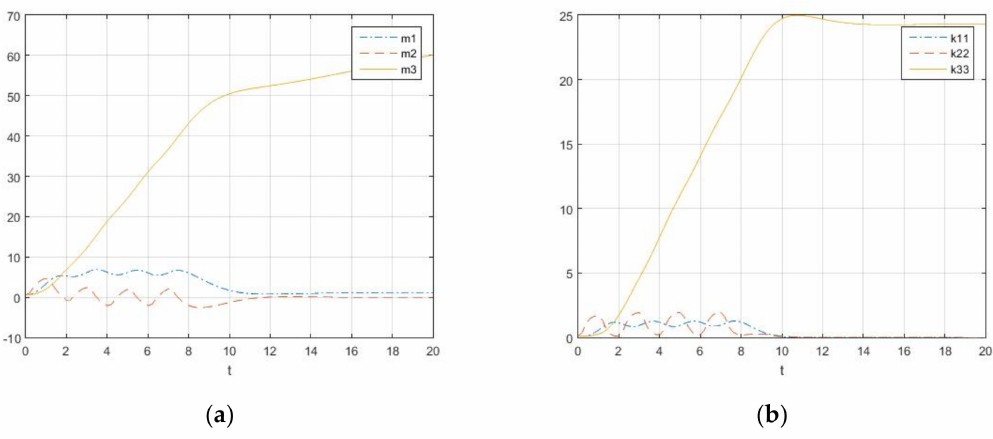
Figure 7. ( a ) Graphs m 1 , m 2 , m 3 at α = 0 ◦ , N = 4; ( b ) Graphs k 11 , k 22 , k 33 at α = 0 ◦ , N = 4.